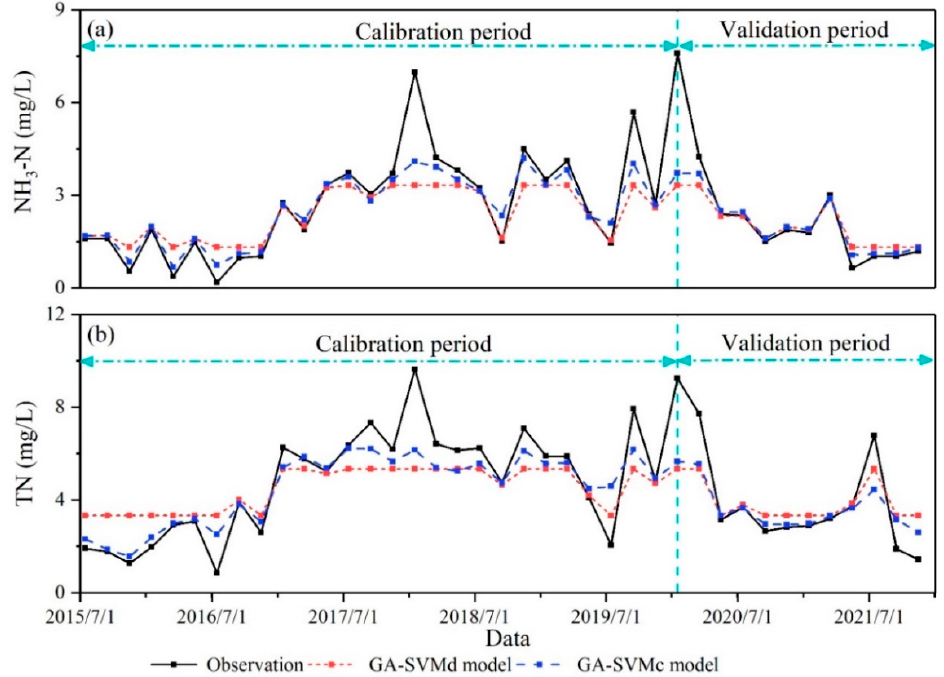
Figure 8. The prediction results of the GA-SVMd model and GA-SVMc model. ( a ) NH 3 -N; ( b ) TN.